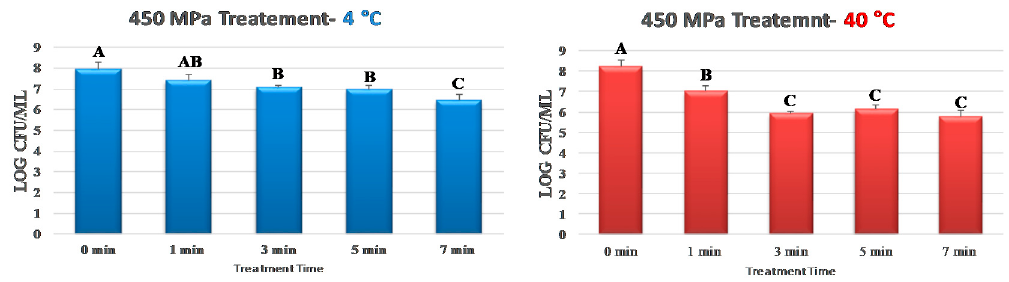
Figure 1. Inactivation of S. aureus by elevated hydrostatic pressure at 4 and 40 °C. Values followed by different upper-case letters are statistically ( p < 0.05) different than each other (pair-wise comparisons, Tukey-adjusted ANOVA).